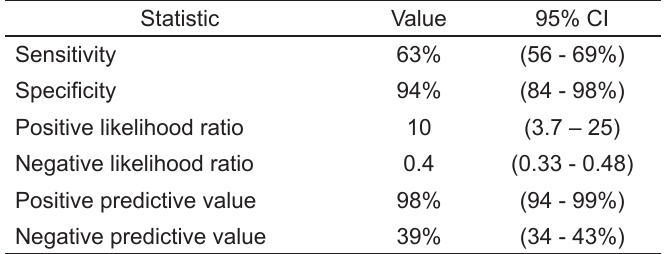
Table 4. Statistical analysis for predicting COVID-19 PCR+ outcome with manifesting all five positive clinical